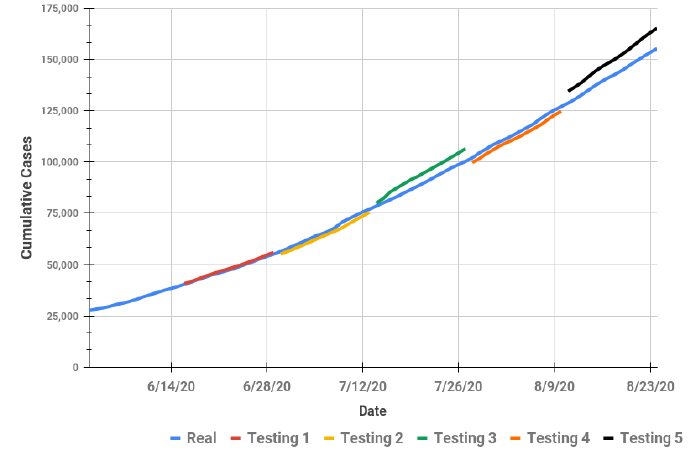
Figure 6. Actual and long-term forecasting for cumulative COVID-19 case using the RNN model.